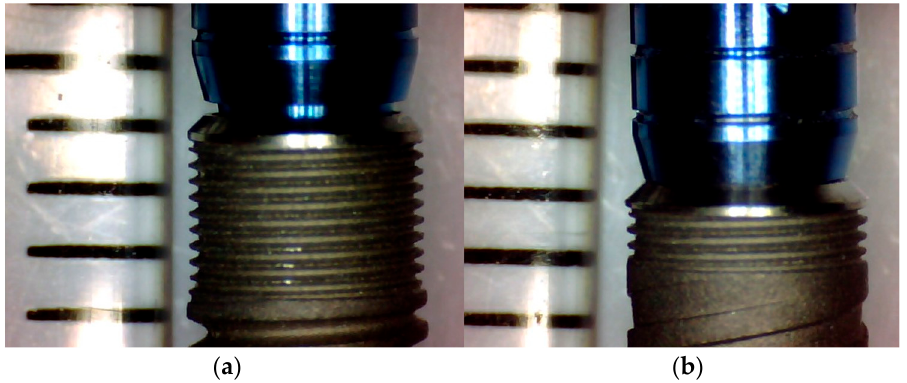
Figure 1. Left: ( a ) Ticare Inhex Standard implant with nine microthreads and a length of 3 mm; Right: ( b ) Ticare Inhex Quattro implant with three microthreads and a length of 1 mm.